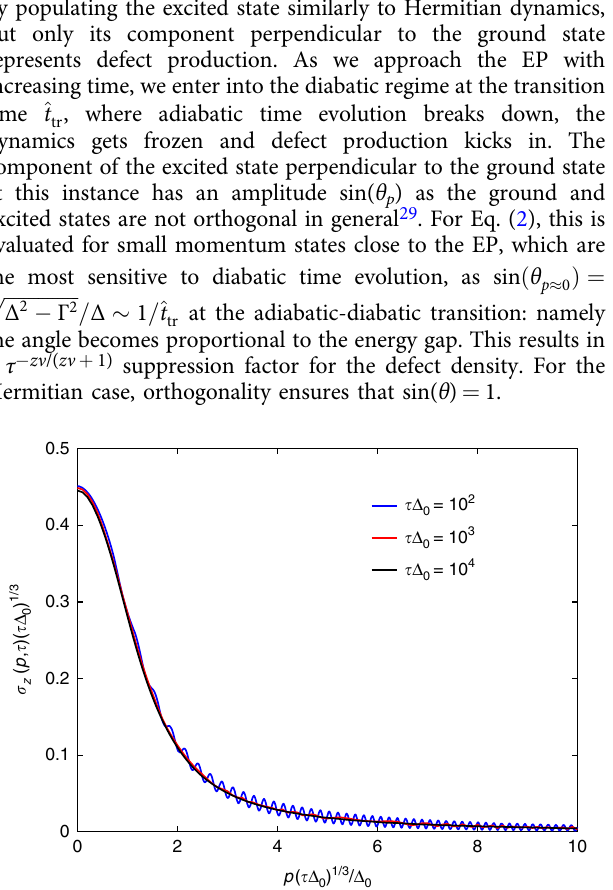
ffiffiffiffiffiffiffiffiffiffiffiffiffiffiffiffiffiffiffi p ð τ (cid:3) t Þ = τ for t ~ τ . The distance from